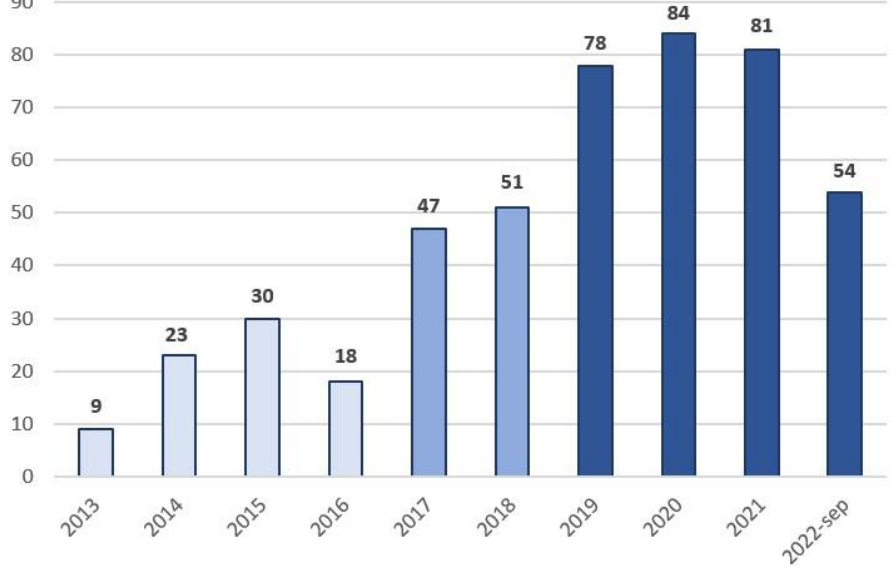
Figure 2. Total number of documents per